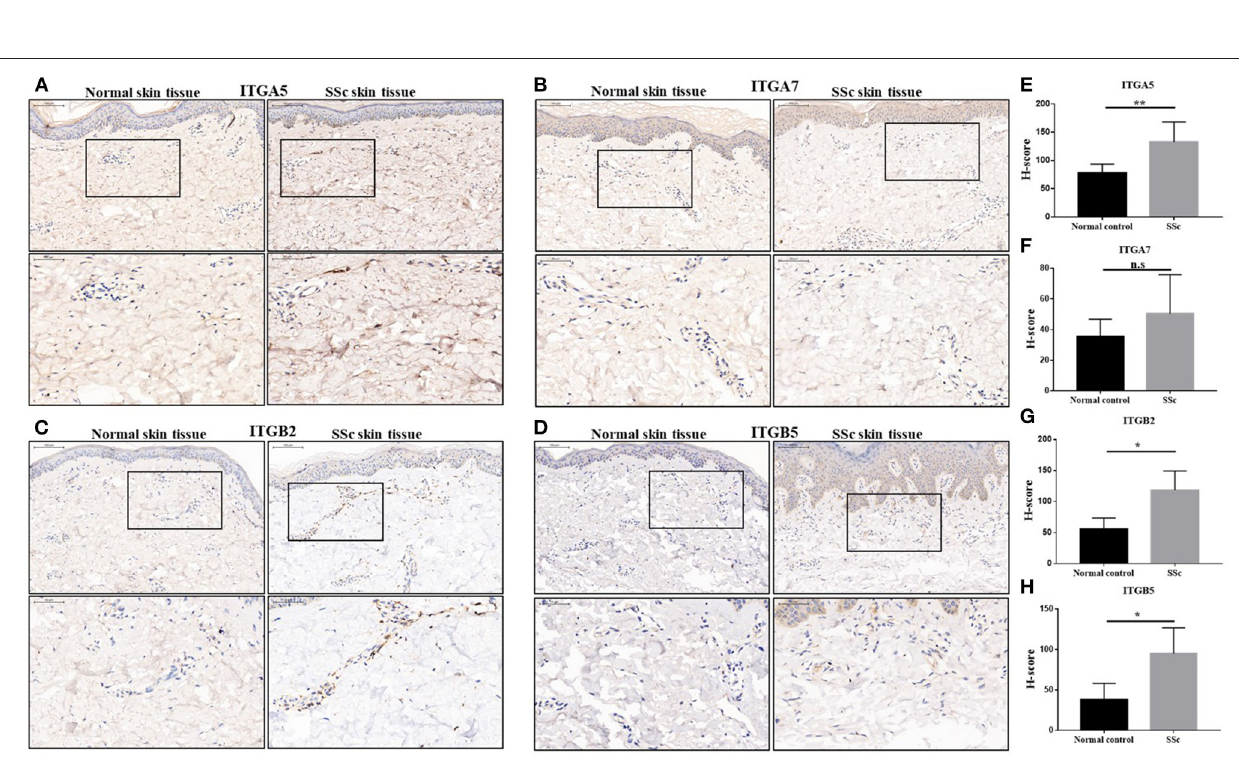
Frontiers in Medicine | www.frontiersin.org